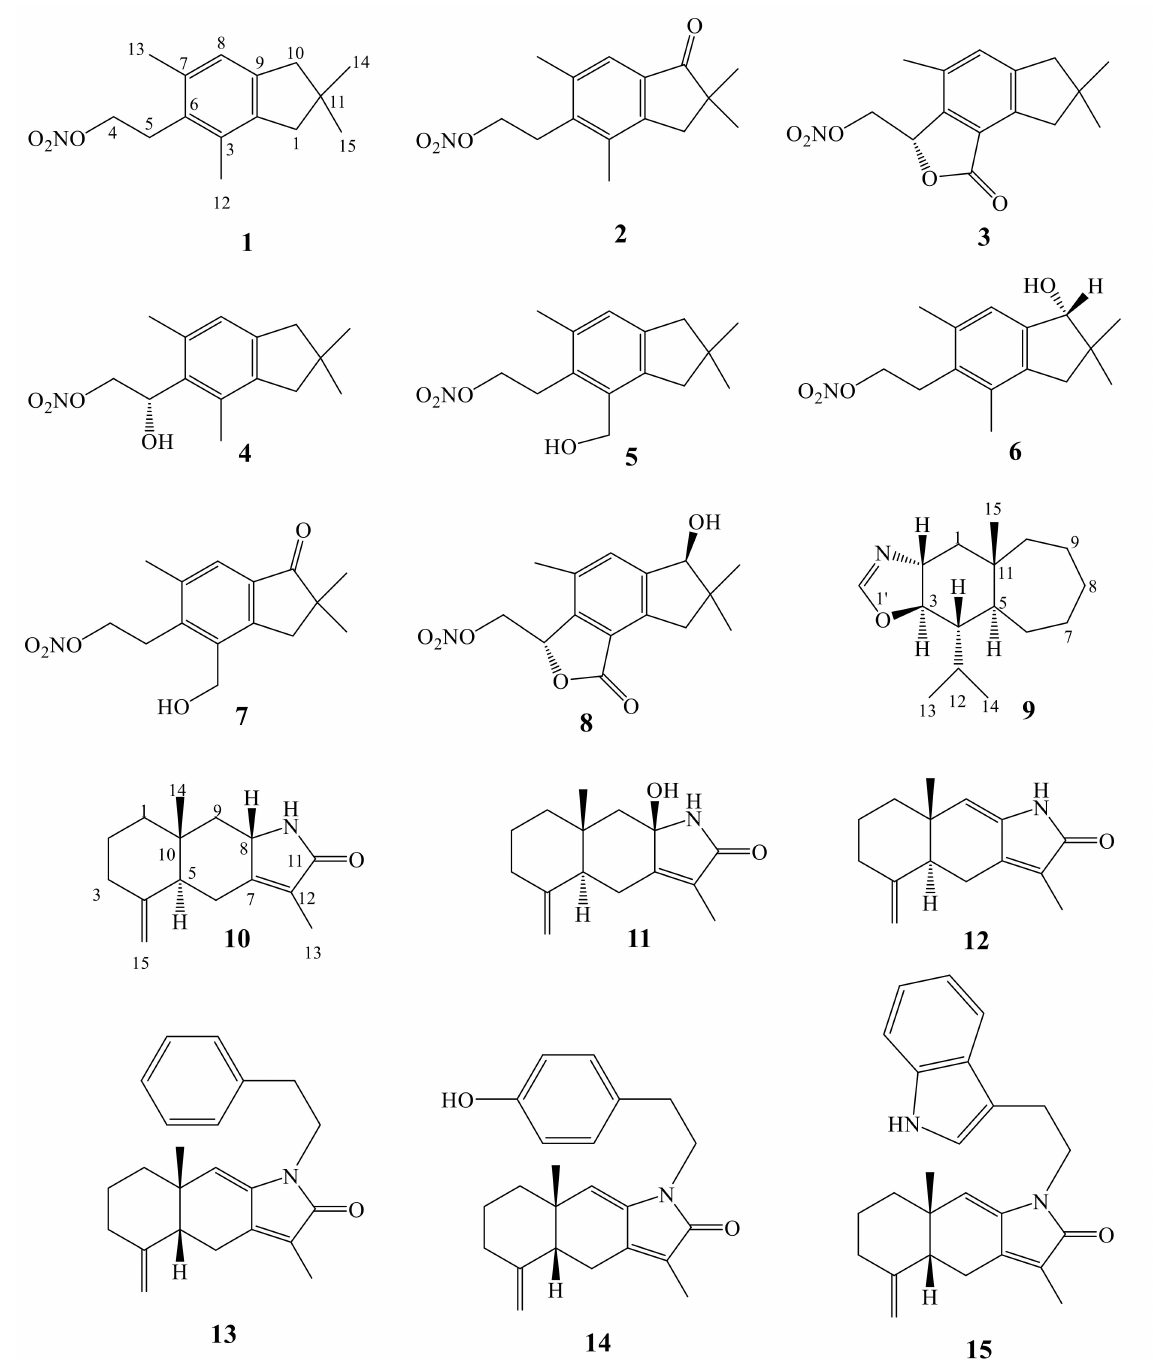
Figure 1. N-Containing sesquiterpenes ( 1 – 15